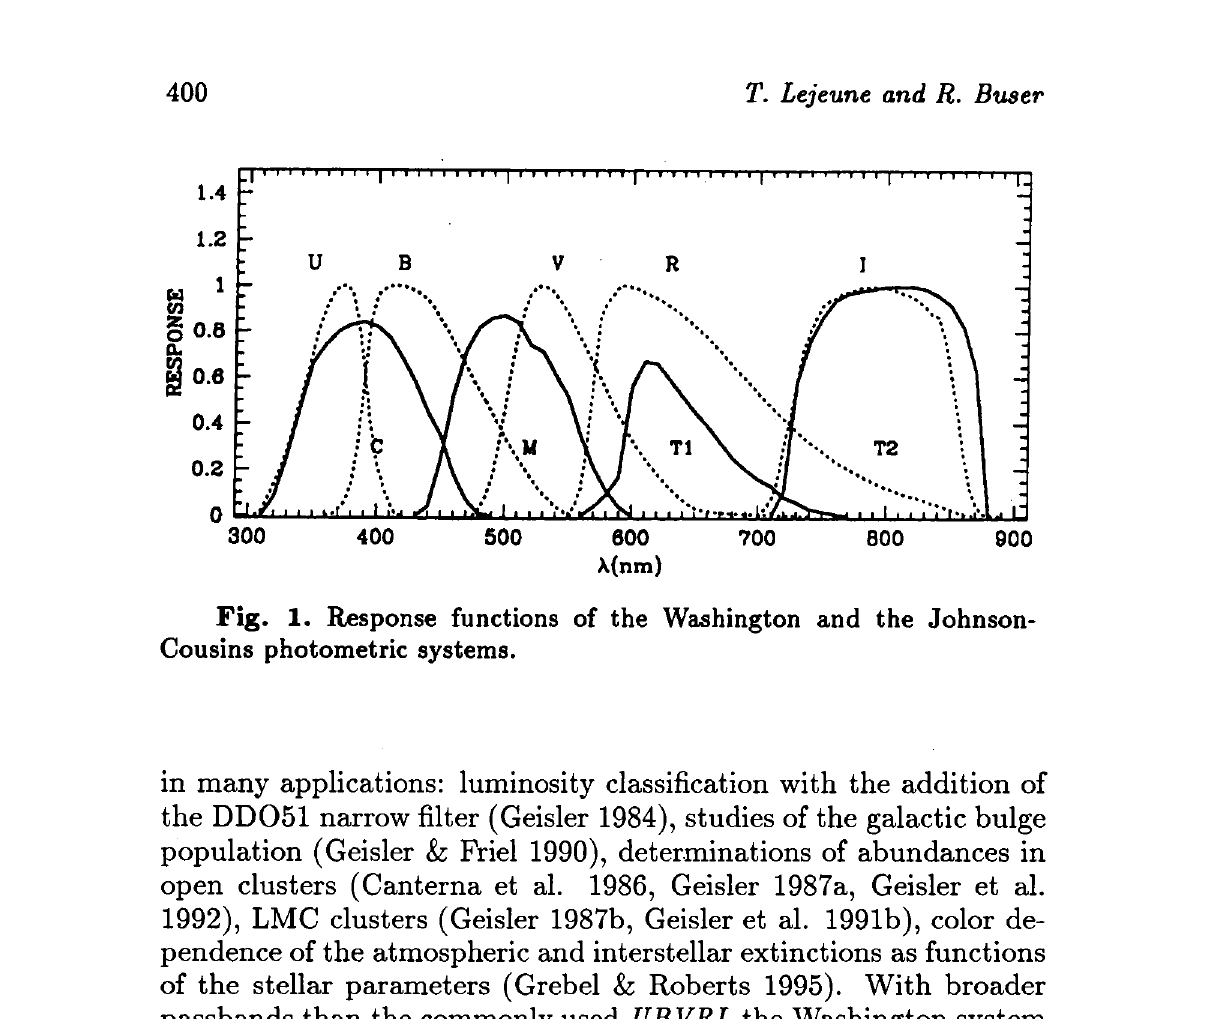
Fig. 1. Response functions of the Washington and the Johnson- Cousins photometric